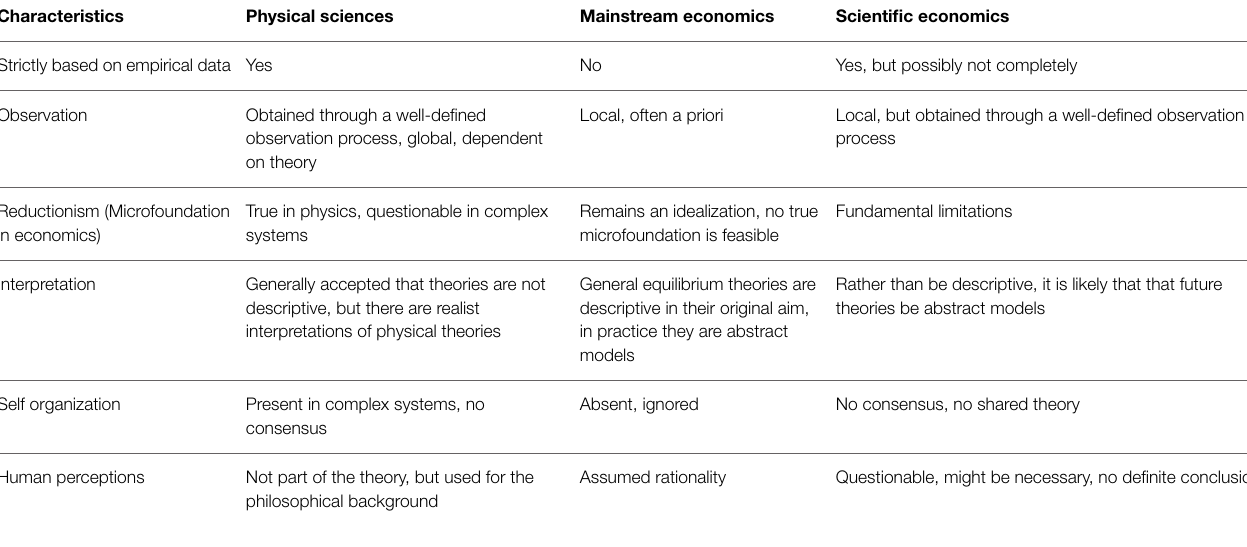
TABLE 1 | Similarities and differences between the physical sciences, mainstream economics, and hypothetical future scientific economics.